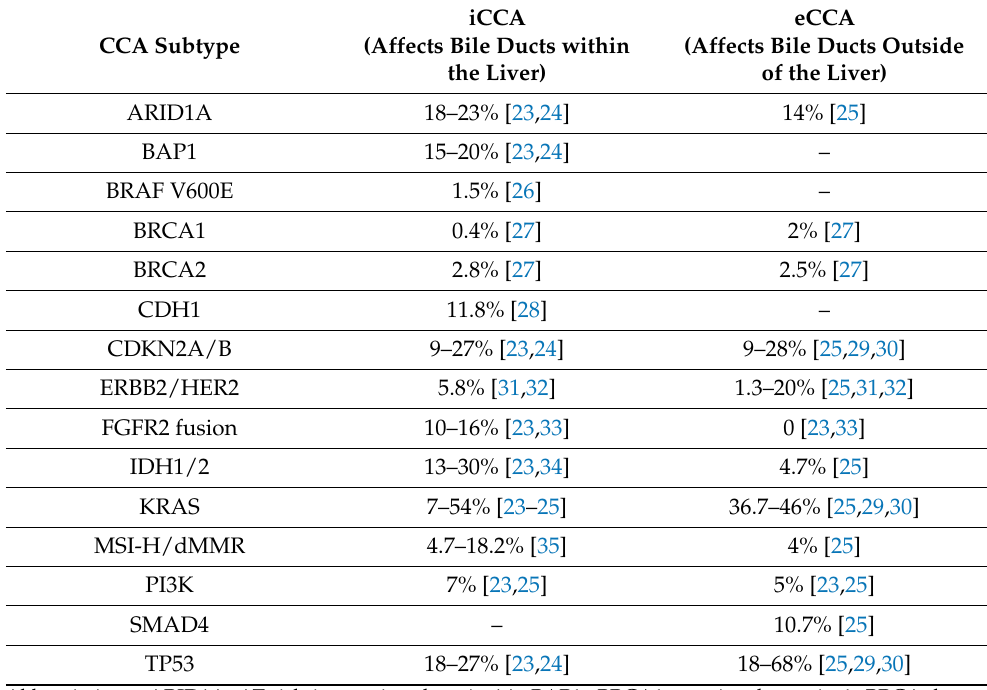
Figure 1. FDA-approved targets found in patients with cholangiocarcinoma. Current genomic targets with FDA-approved therapies in cholangiocarcinoma. MSI-H, microsatellite instability-high; dMMR, deficiency in mismatch repair; TMB-H, tumor mutation burden-high ( ≥ 10 mutations/mb). Table 1. The frequency of genetic alterations according to the anatomic location of CCA .